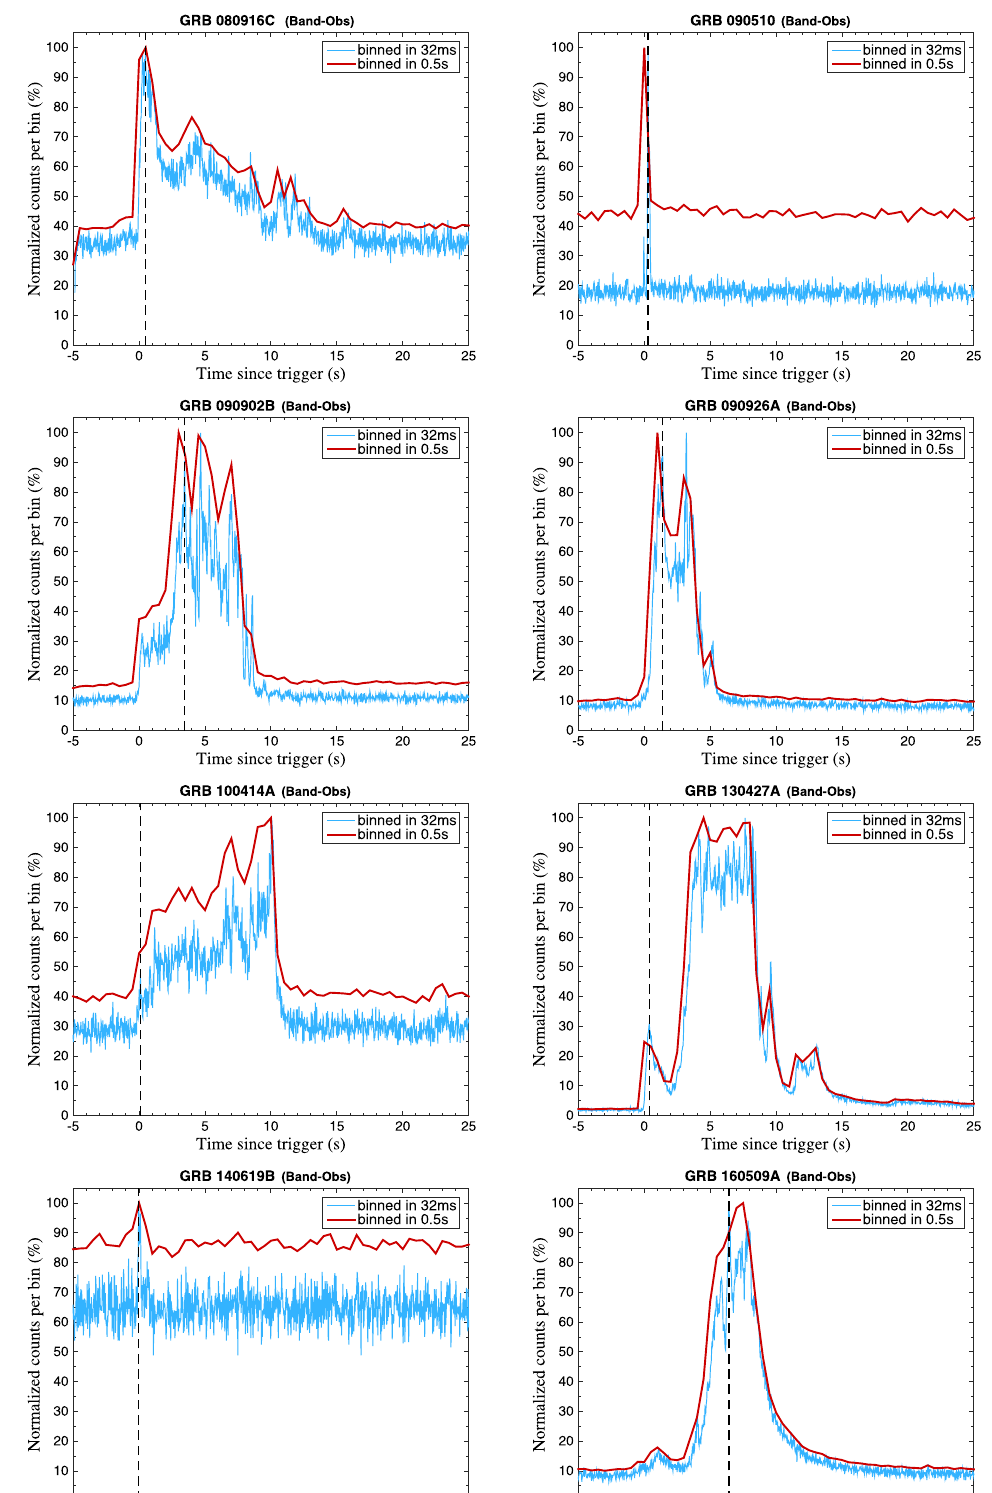
Fig. 1 The light curves in Band-Obs of 8 GRBs. The x -axis refers to the time t obs /( 1 + z ) . The thin (blue) curves are the light curves binned in 0.032 s and the thick (red) curves are those binned in 0.5 s. The